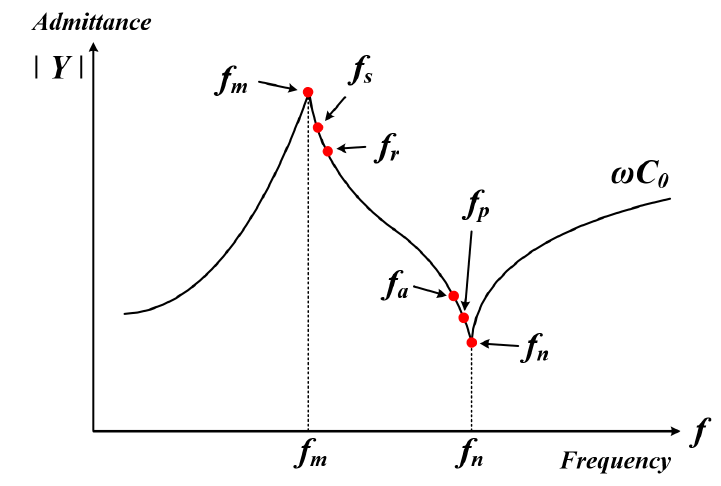
Figure 2. Admittance graph of the PT. Table 1. Frequency characteristics of the